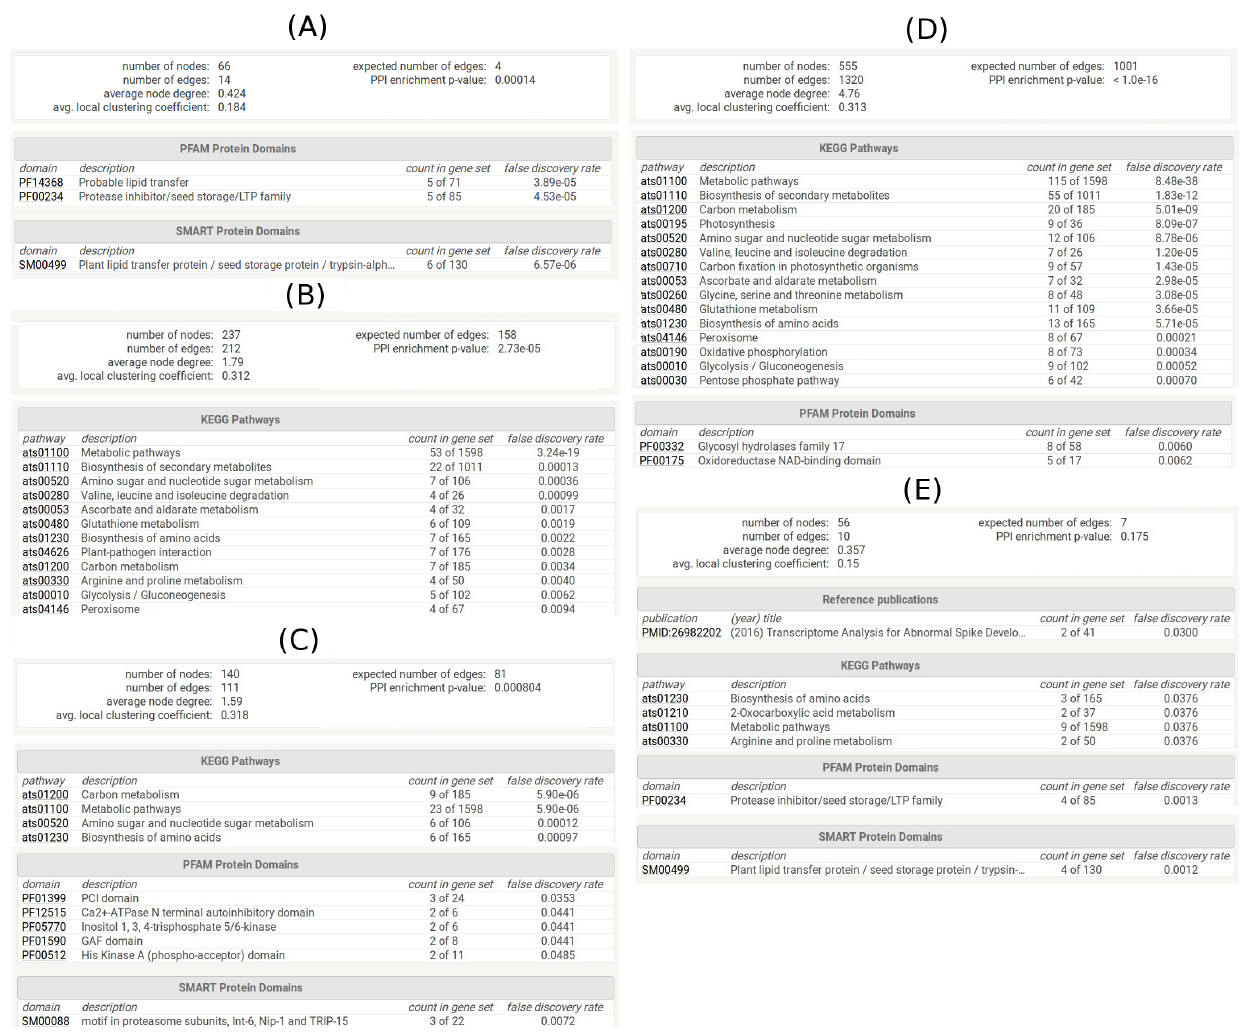
Figure 4. The gene ontology enrichment analysis for DEGs genes of (A) D.ctrl , (B) H.ctrl, (C) HD.M, (D) M.ctrl, and (E) HD.ctrl profiles.